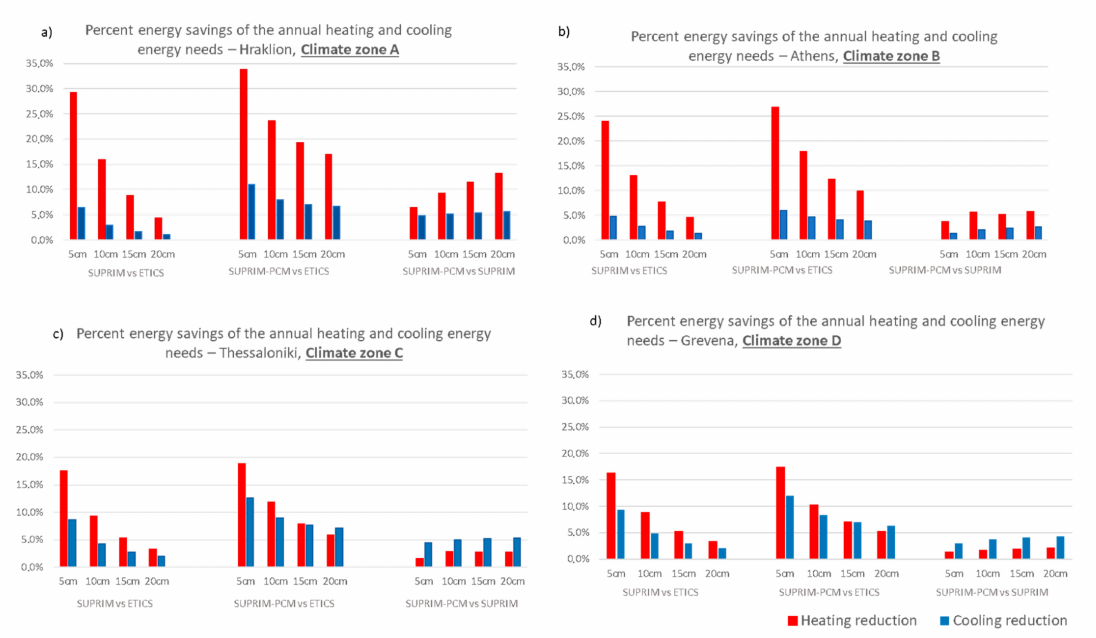
Figure 6. Percentage energy saving of the annual heating and cooling energy needs estimated for the various examined scenarios and for climate zone A, B, C, and